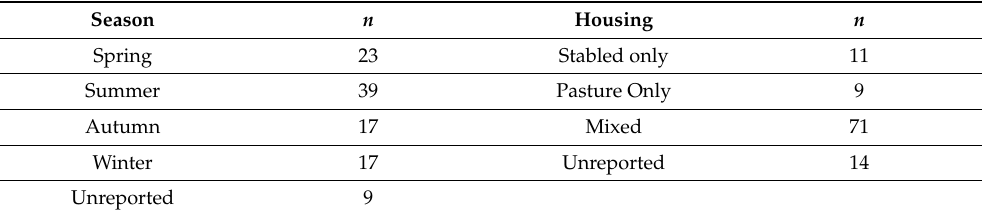
Table 2. Reported season of occurrence and type of housing in 105 equine cases of suture exostosis.